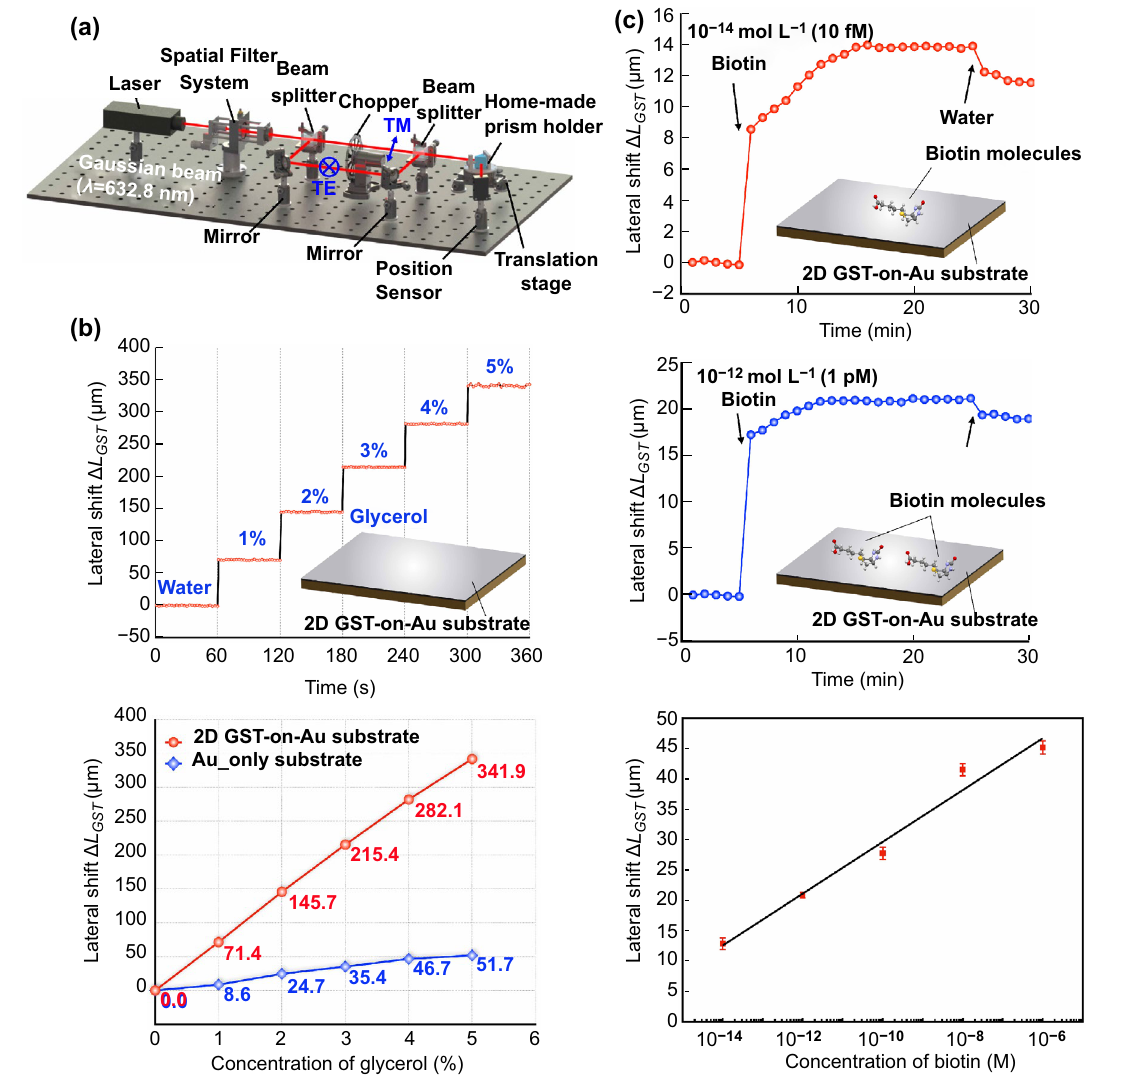
Fig. 2 a Optical setup for measuring differential lateral position shift between p ‑ and s ‑polarized light. b Evaluation results of measuring glyc‑ erol solutions. c Real‑time detection of biotin molecules based on lateral position shift